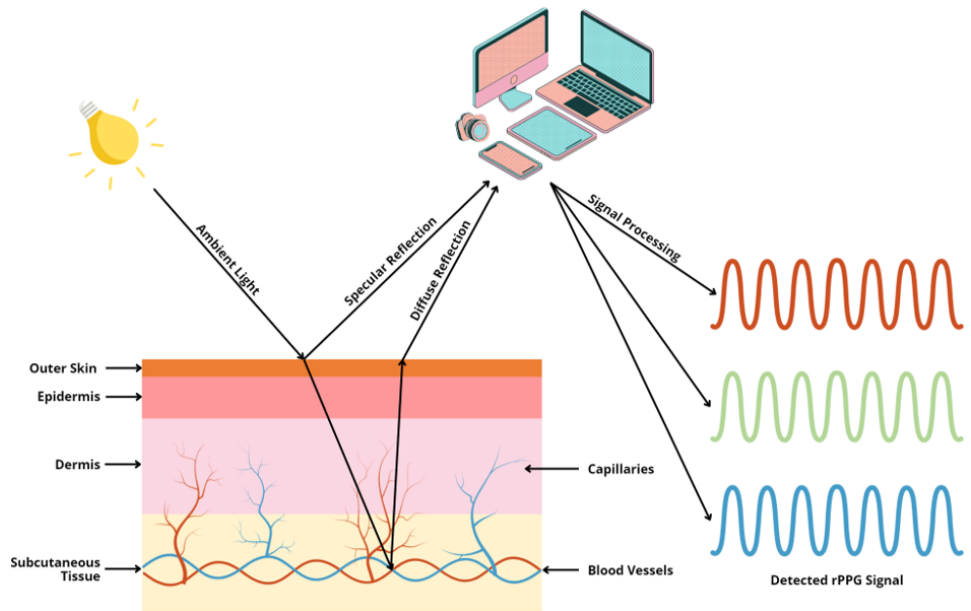
Figure 4. A working principle of rPPG. This figure was modified from [53]. The specular component gives the information on the skin’s surface, which does not have any physiological signals. The diffused counterpart gives the subtle change in blood flow, which provides physiological information after meticulous signal processing.